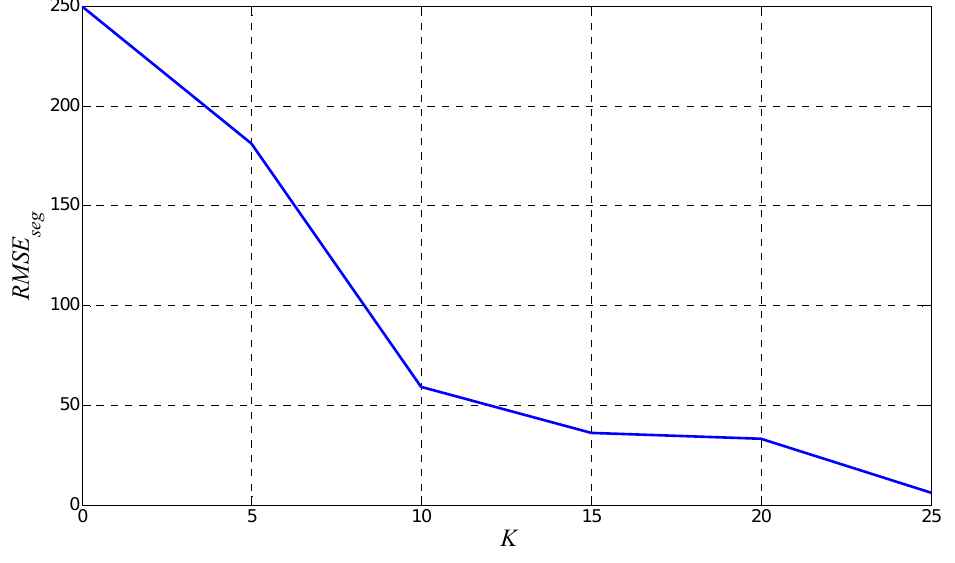
from the segmentation test results. Figure 10. RMSE seg